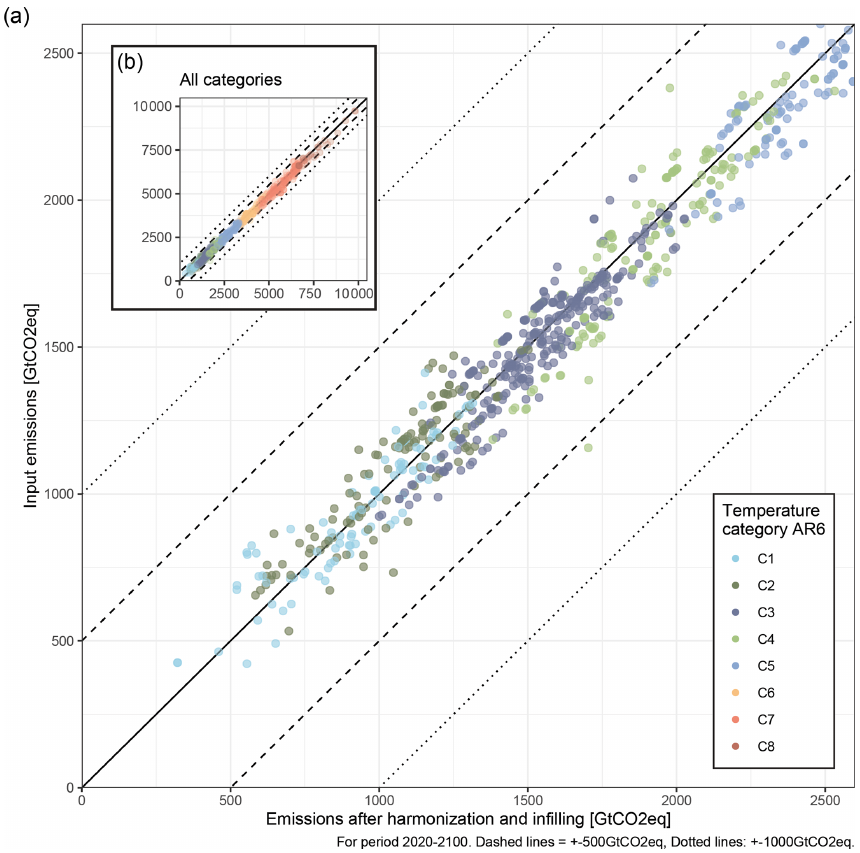
Figure 8. Kyoto gases for 2020–2100, infilled and model reported by category. Each dot represents one long-term full-century scenario. If model input would perfectly align with the used historical database and model all emissions species or if harmonisation and infilling cancel each other exactly, the input GHG emissions would be the same as the GHG emissions after harmonisation and infilling. A spread on both sides of the line would be expected if historical emissions uncertainty would dominate, and the use of different modelled historical emissions would not have a particular bias compared to the emissions estimate used for harmonisation. On the other hand, if many scenarios miss information on some important GHGs, dots would appear predominantly on the right of the